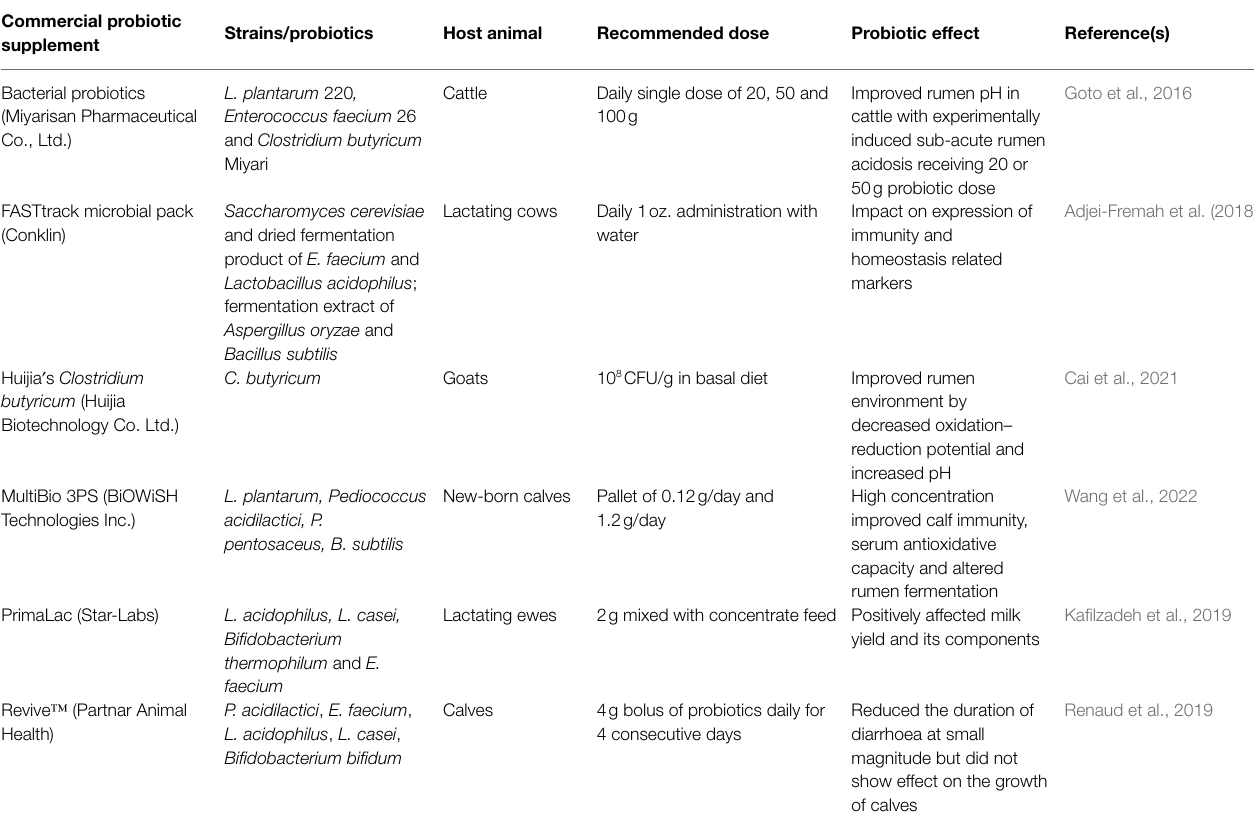
TABLE 2 | Commercial probiotic oral supplements that demonstrated specific health benefits in dairy